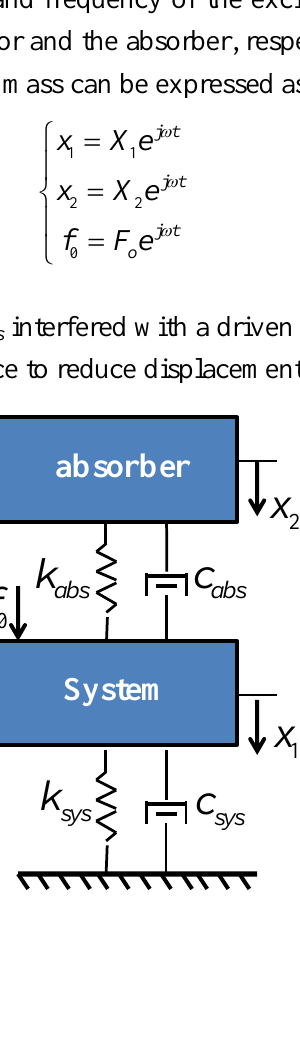
interfered with a driven force f sys